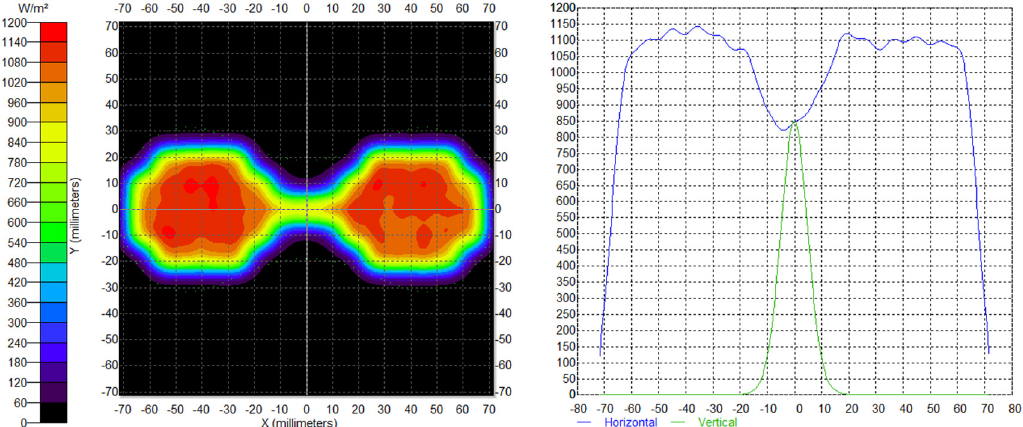
Figure 3. The simulation of irradiance.